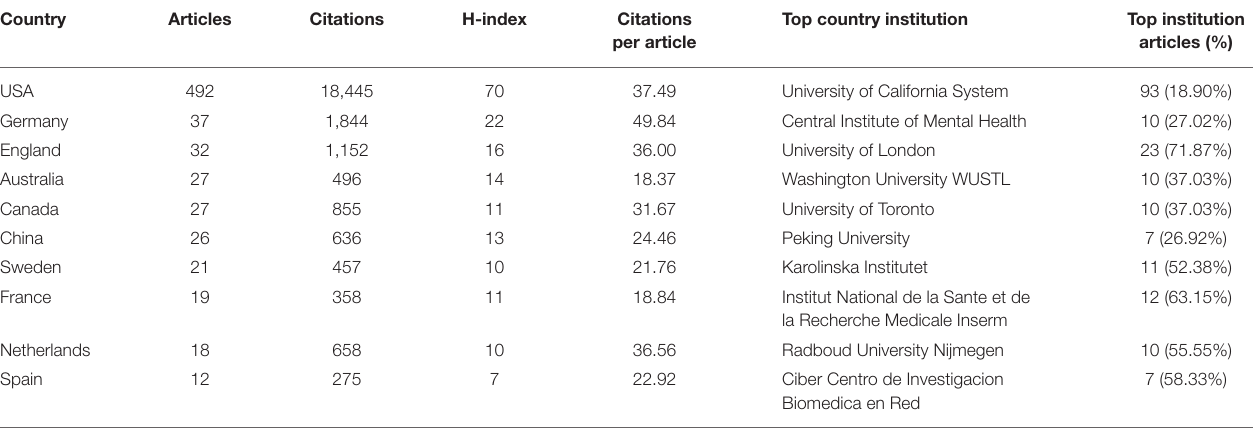
TABLE 1 | Top countries and country institutions on substance-related disorders research. Country